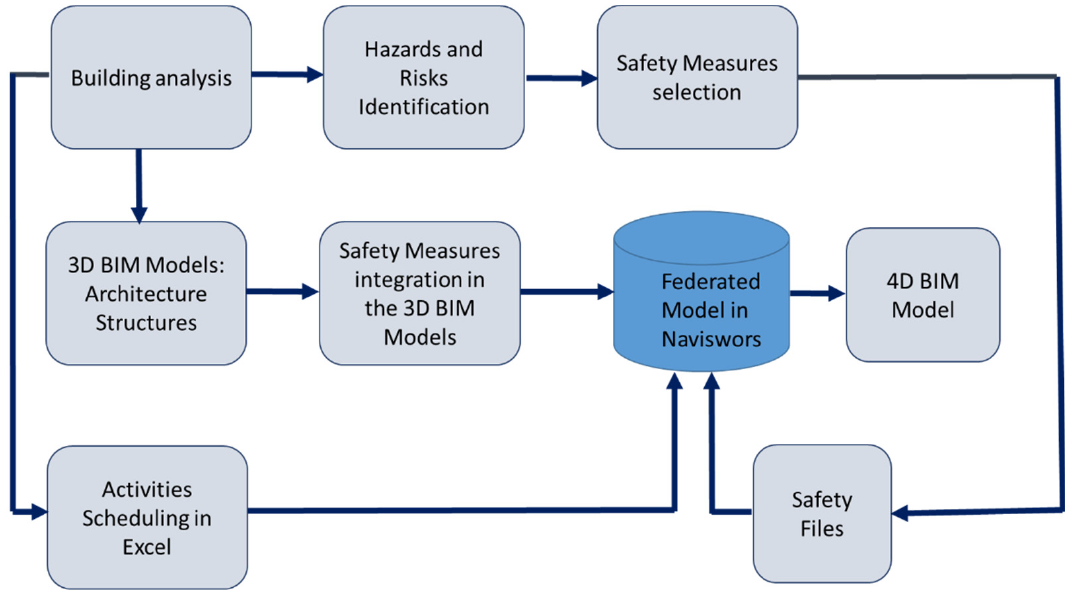
Figure 1. Methodology diagram.